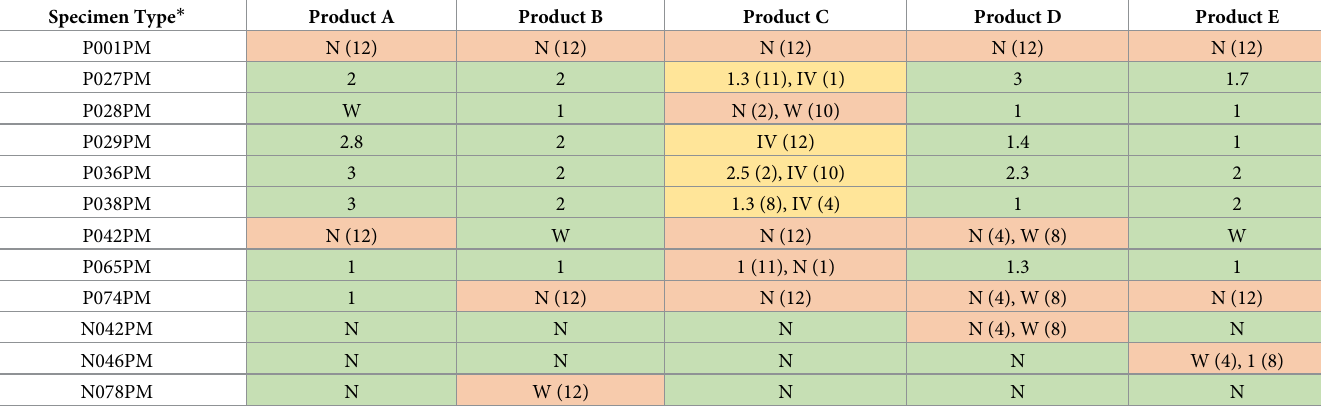
Numerical values provide the average result for the scale of 1–3, where N and/or W are indicated as appropriate. IV indicates invalid results. Some specimens provided mixed results across the replicates and are noted with multiple indicators. For yellow and red cells, values in parentheses indicate the number of RDT units out 12 that yielded the specific result. Results provided in green cells are across 12 RDTs. * Green cells = expected results, Yellow cells = include invalid results with any of the 12 RDTs during qualification, Red cells = include unexpected results with any of the 12 RDTs during